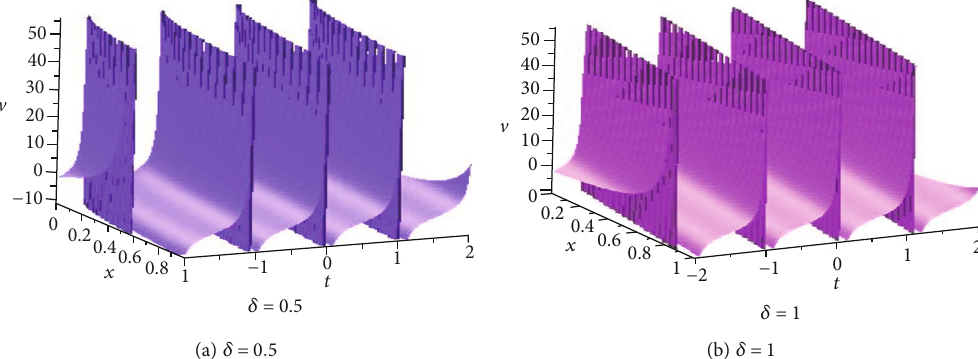
Figure 3: Periodic wave solution for m for complete